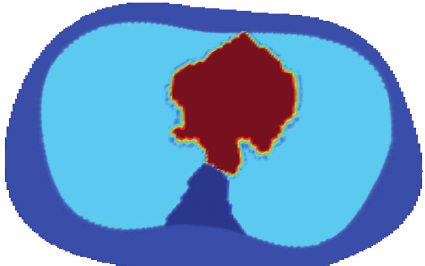
Figure 2: Schematic diagram of the internal tissue and organ distribution based on prior